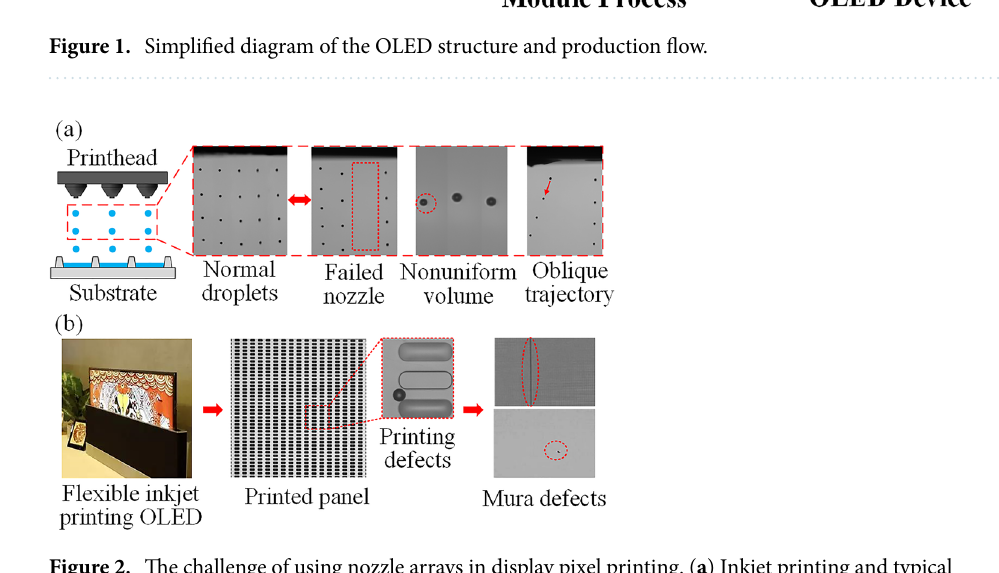
Figure 2. The challenge of using nozzle arrays in display pixel printing. ( a ) Inkjet printing and typical problems. ( b ) Flexible inkjet printing OLED screen released by TCL at the Consumer Electronics Show in 2020 and example defects in a printed